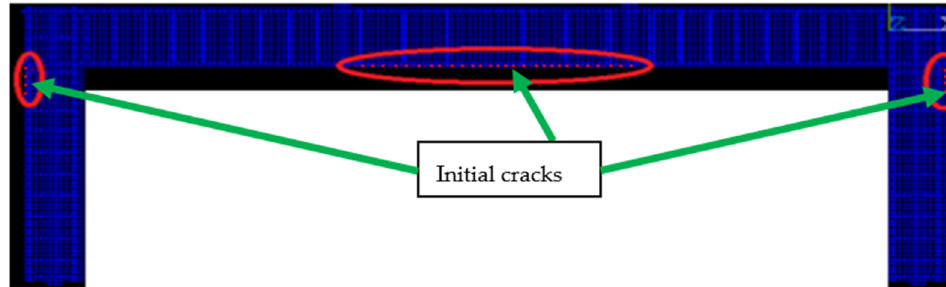
Appl. Sci. 2022 , 11 , x FOR PEER REVIEW Figure 14. Initial crack in sample F 0 . Figure 14. Initial crack in sample F 0 .